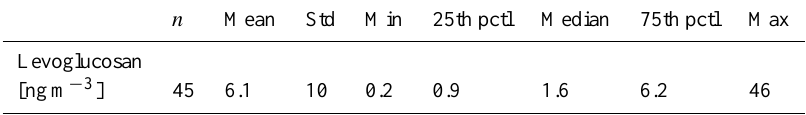
Table 1. Descriptive statistics for